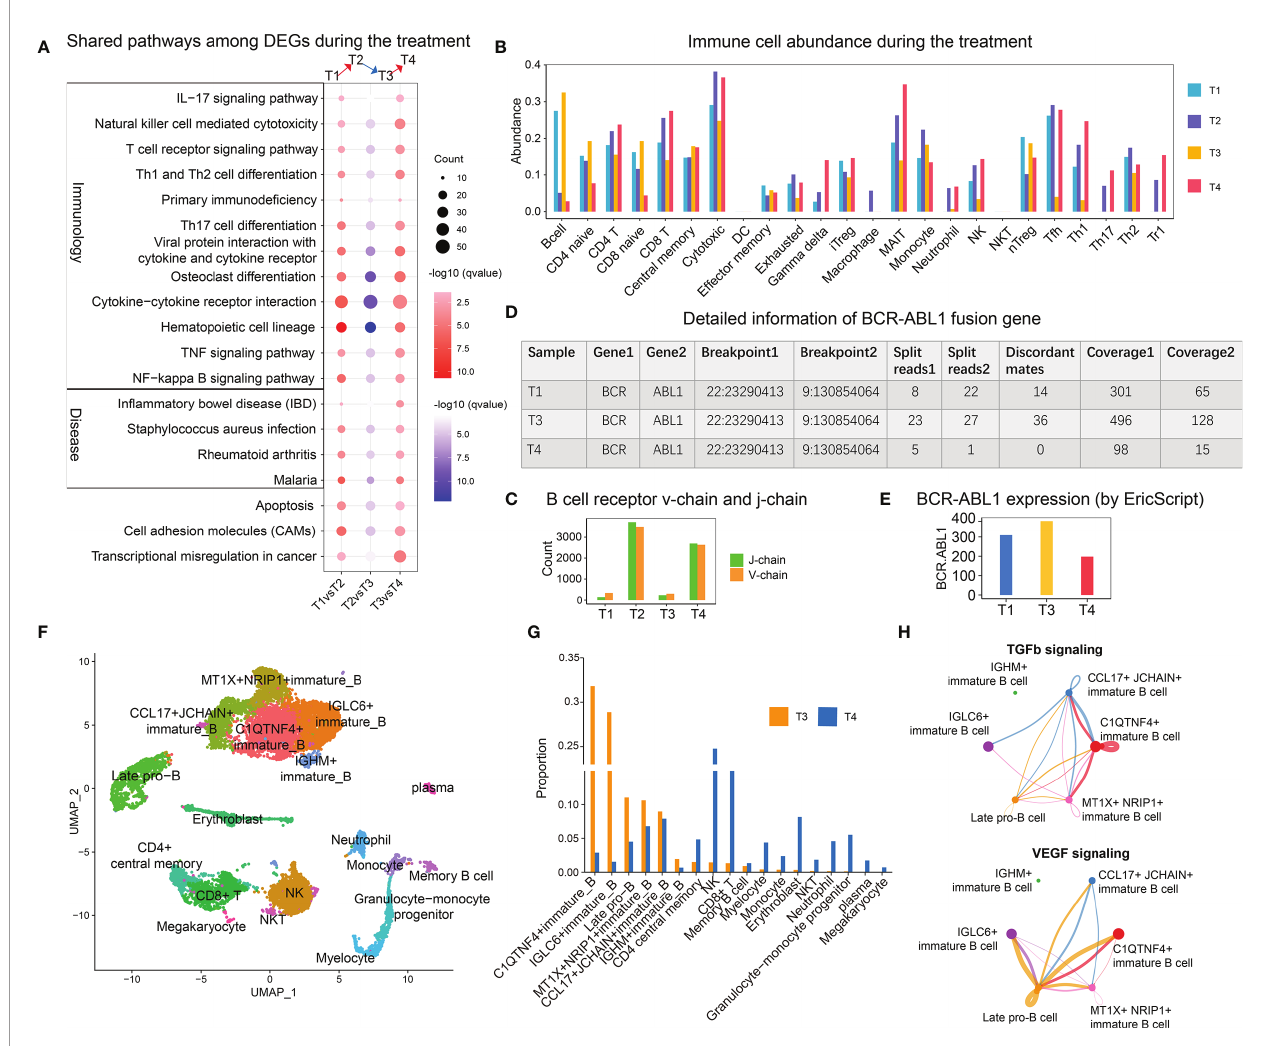
FIGURE 3 | Transcriptome features relevant to treatment and disease progression. (A) Shared enriched pathways with differentially expressed genes during disease progression and treatment. The red color indicates the pathway enriched with upregulated genes [T1 vs . T2 (up) and T3 vs . T4 (up)], whereas the blue color indicates the pathway enriched with downregulated genes [T2 vs . T3 (down)]. (B) The distribution of immune cell abundance during disease progression and treatment. (C) The abundance of B cell receptor V-chain and J-chain per sample. (D) Detailed information on the BCR – ABL1 fusion gene in each sample. (E) Expression of BCR – ABL1 in the T1, T3, and T4 samples. (F) Two-dimensional uniform manifold approximation and projection visualization of the cellular composition of the T3 and T4 samples. (G) Bar plot of the cell proportions of the T3 and T4 samples. (H) Circle plot showing the inferred TGF- b and VEGF signaling networks. The size of the dot represents the cell number. A line connecting two cell types indicates a receptor – ligand interaction between them. The thickness of the line represents the signal